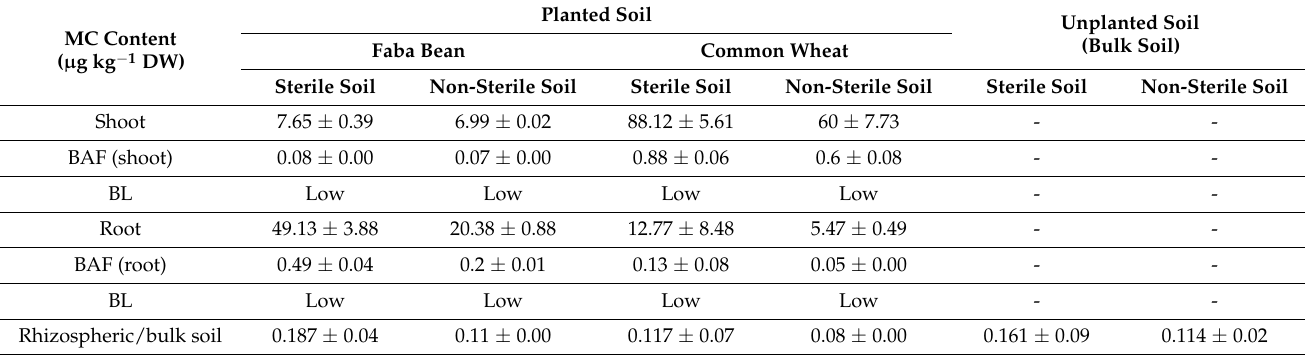
Table 3. MC content in bulk soil and soil-plant system, and their bioaccumulation factor (BAF) in shoot and root tissues of faba bean ( V. faba L., var. Alfia 321 ) and common wheat ( T. aestivum L., var. Achtar ) plants. Data are shown as mean ± standard deviation ( n = 3). The bioconcentration level (BL) was evaluated based on BAF values. Planted Soil Unplanted Soil MC Content ( µ g kg − 1 DW) Sterile Soil Non-Sterile Soil Sterile Soil Non-Sterile Soil Sterile Soil Non-Sterile Soil Shoot 7.65 ± 0.39